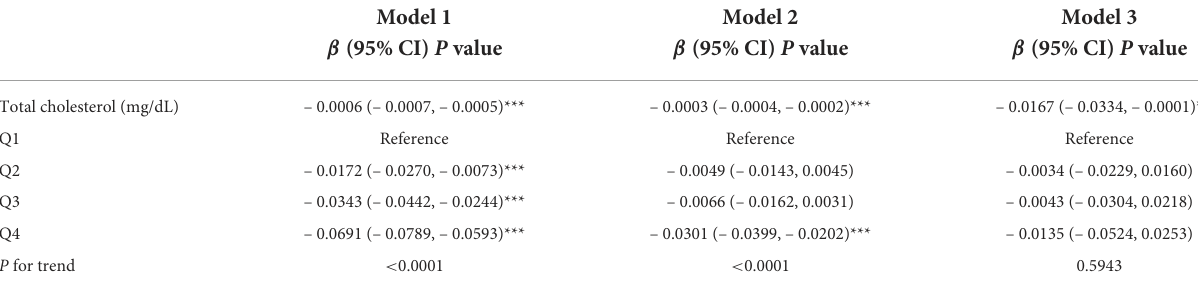
TABLE 3 Association of serum TC with lumbar spine bone mineral density in 7,092 female participants aged 20–85 years.